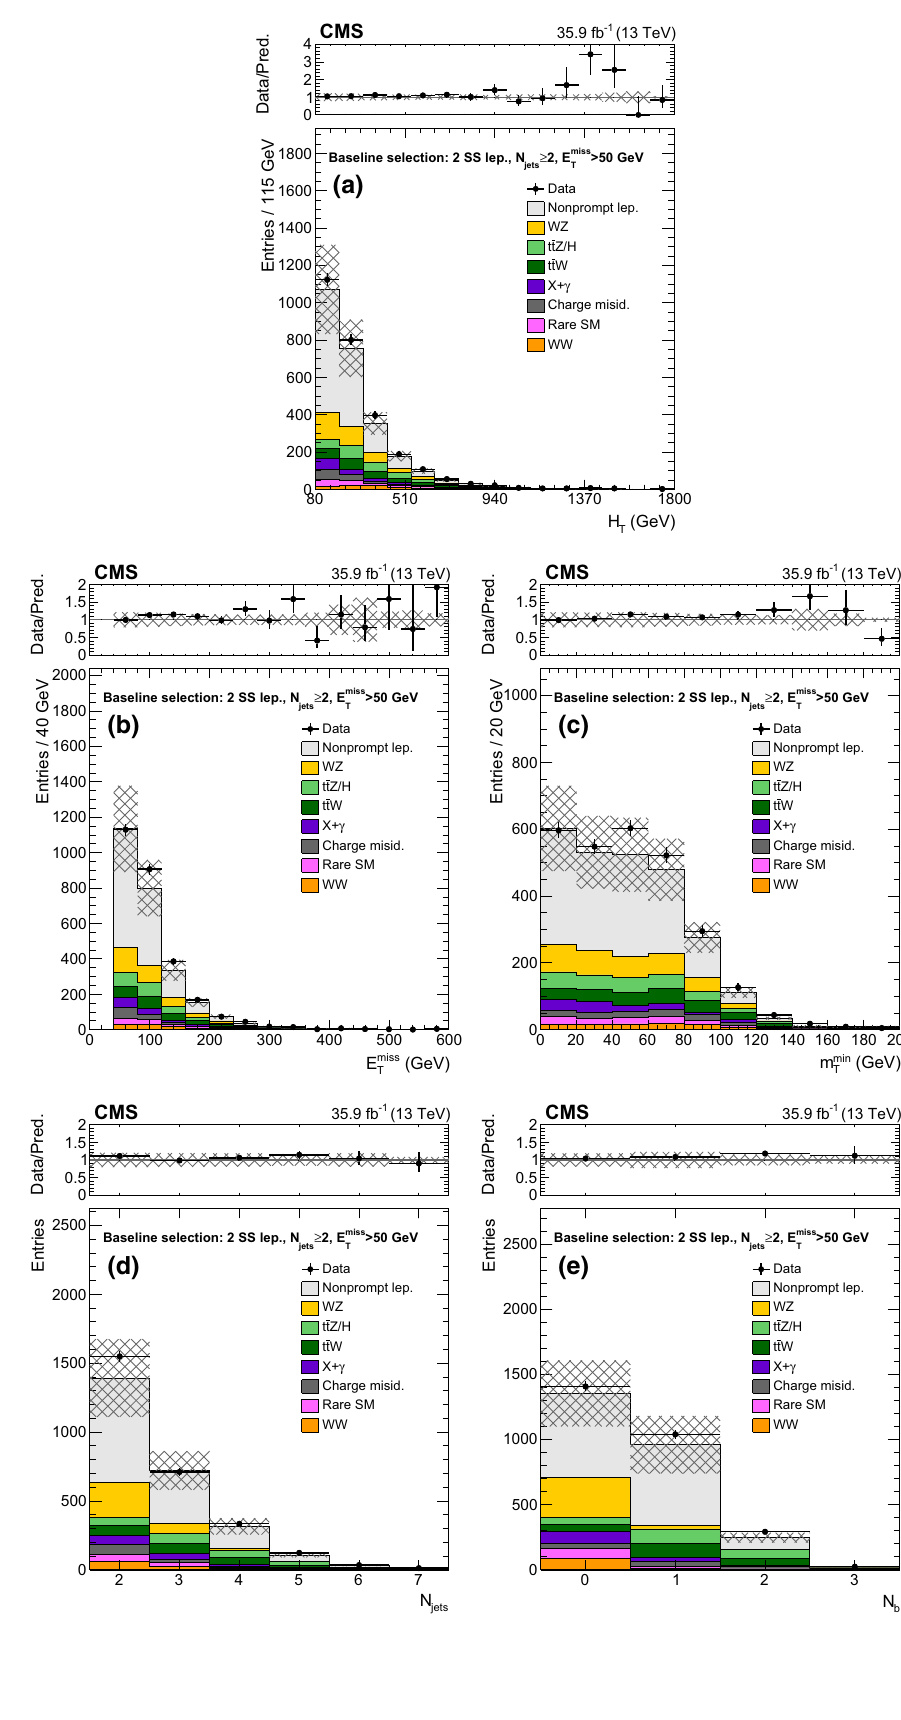
Fig. 3 Distributions of the main analysis variables: H T ( a ), E miss ( b ), m min ( c ), N jets ( d ), T T and N b ( e ), after the baseline selection requiring a pair of SS leptons, two jets, and > 50GeV. The last bin E miss T includes the overflow events and the hatched area represents the total uncertainty in the background prediction. The upper panels show the ratio of the observed event yield to the background